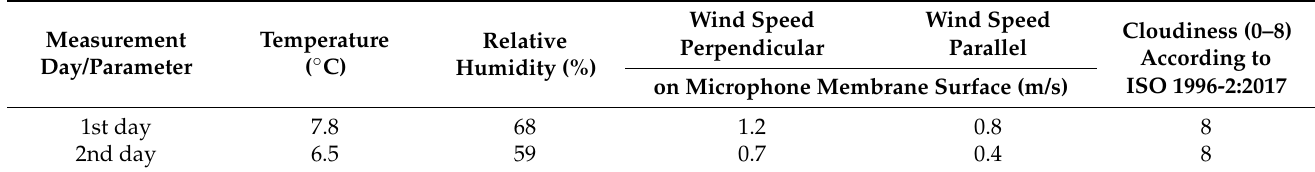
Table 1. Meteorological conditions during UAV noise measurements and respondents’ assessments.